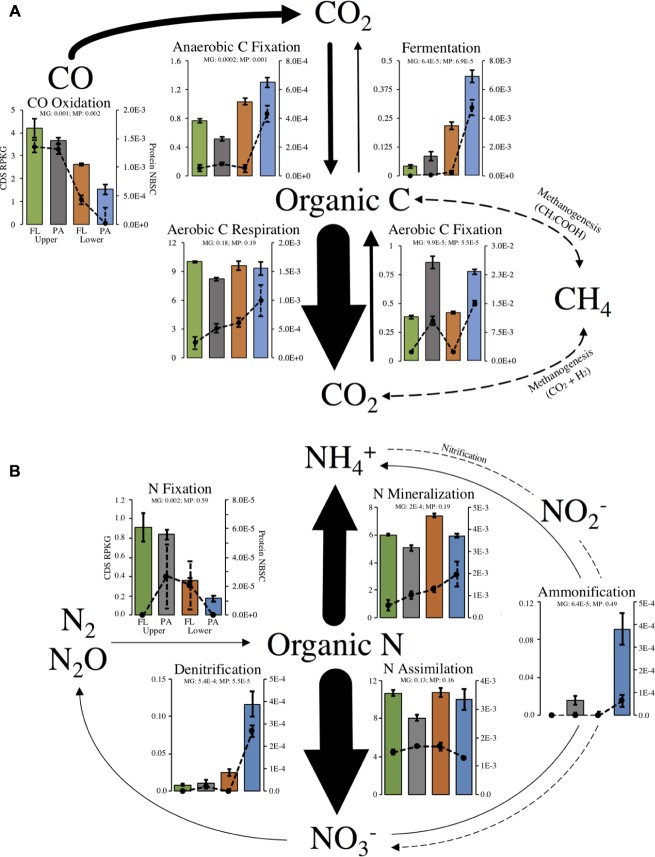
Major processes within the (A) C- or (B) N-cycles and relative abundance of biological marker genes that catalyze fluxes. Arrow sizes show relative abundance of total marker gene RPKG for each process. Bar plots show marker genes (left-axis) and lines plots show marker proteins (right-axis). Dotted arrows represent a process with no recovered marker genes or proteins. Axis labels and scales are equivalent for all plots and only drawn on one plot for clarity. Significantly non-equal potential across habitats was determined with a FDR-corrected ANOVA: q < 0.05). Error bars represent standard error of the mean for each set of replicate samples. MP, metaproteome; MG, metagenome in ANOVA results.